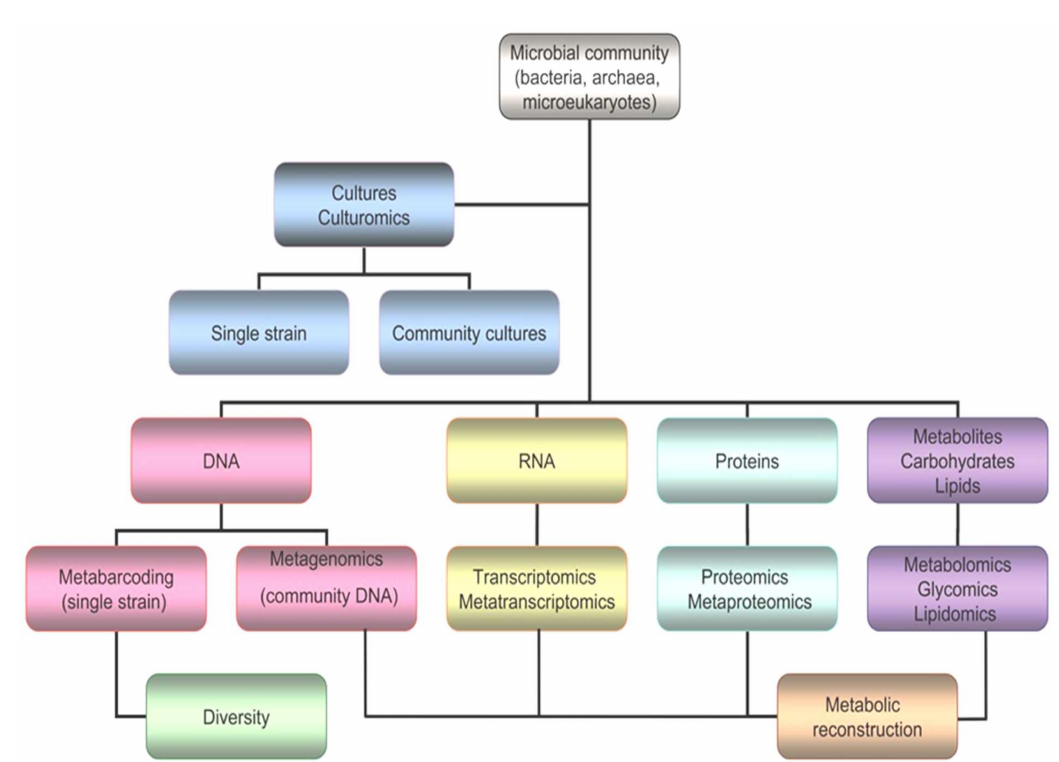
Figure 5. Workflow for omics, including genomics, transcriptomics, proteomics, glycomics, lipidomics and